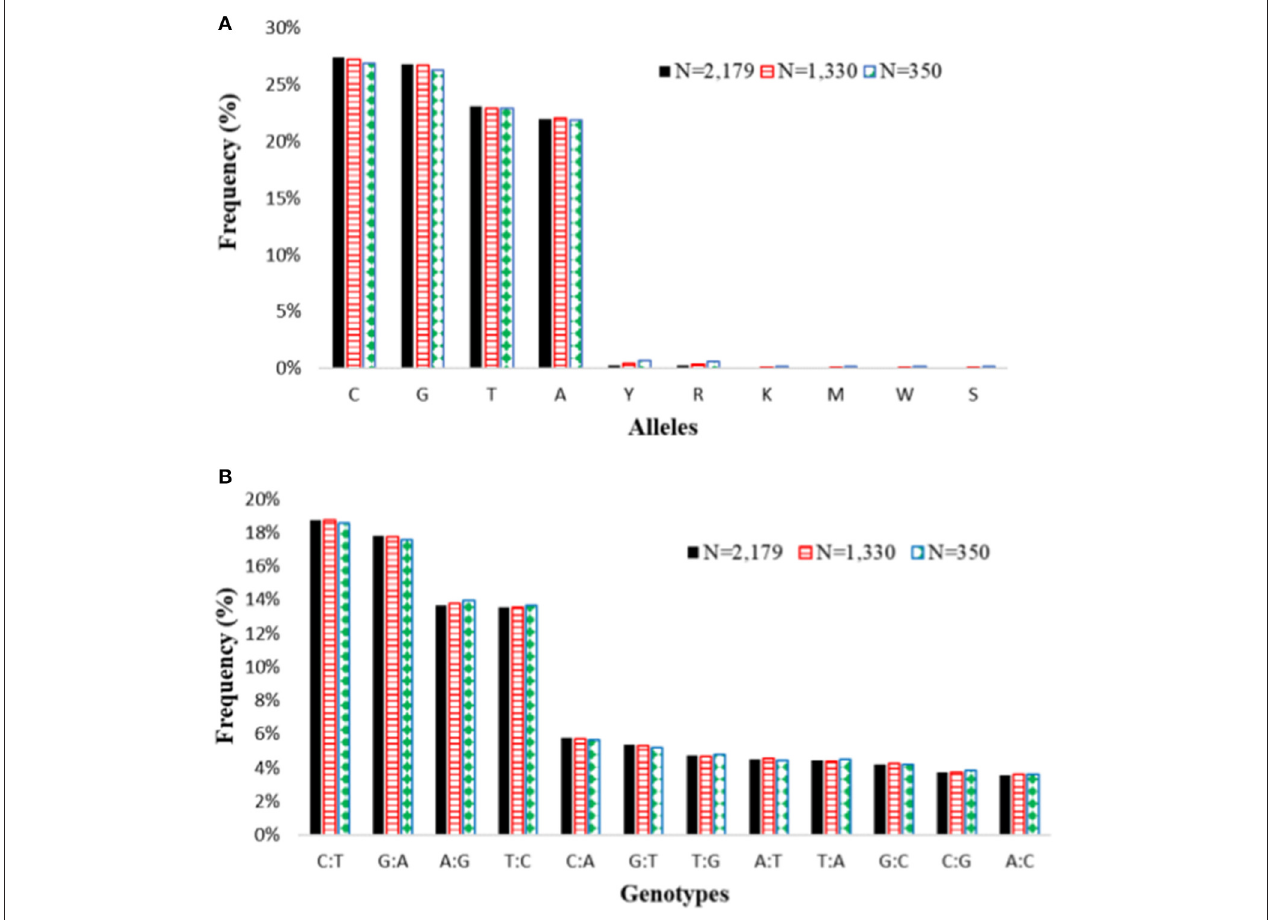
FIGURE 6 | Summary of (A) allele frequencies and (B) genotype frequencies of the entire O. glaberrima accessions ( N = 2,179) based on 3,834 polymorphic SNPs as compared with a core set of 1,330 accessions using 3,781 polymorphic SNPs, and a mini-core set of 350 accessions using 3,709 polymorphic SNPs. Nucleotide codes are as follows: A, adenine; C, cytosine; G, guanine; T, thymine; Y, C or T; R, A or G; K, G or T; M, A or C; W, A or T; S, G or C (http://www.bioinformatics.org/ sms/iupac.html; accessed in Sept.